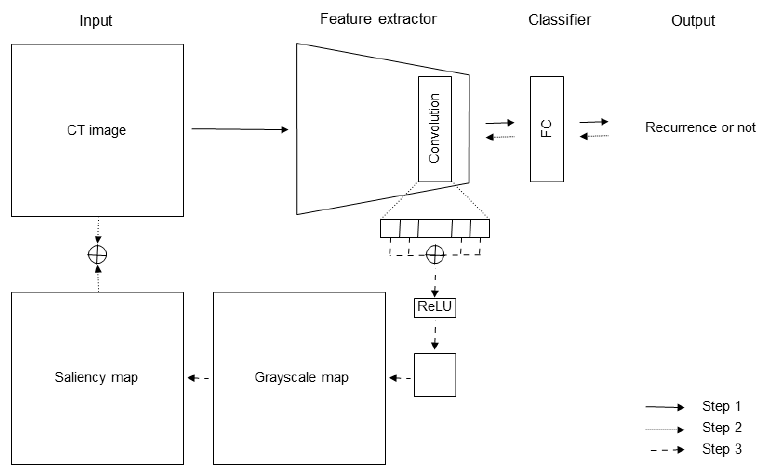
Figure 3. Outline of the Grad-CAM model. In a nutshell, Grad-CAM [23] works by inputting an image of the object to be visualized into a trained model and then outputting a heat map of the final convolutional layer in the model that reacts to the object. Step 1 is a forward propagation phase. A trained model is used to classify the target to be visualized. In our study, the target was a CT image from patients predicted with early postoperative recurrence. Grad-CAM visualizes features of these images to highlight the features that are most impacted by the model. The CT image is fed into the model, and the output of the final convolutional layer in the model is obtained. Step 2 is the backpropagation phase, wherein the results responding to only the class (image from patient with recurrence) to be visualized are obtained in the backpropagation. Step 3 is an image synthesis phase, wherein the synthesized image is obtained by multiplying the images created in Step 1 and the matrices in Step 2. The synthesized image is normalized after passing ReLU and finally resized to the original image size to complete the heat map creation. Finally, the heat map and original image (CT image) are concatenated. FC, fully connected layer; ReLU, rectified linear